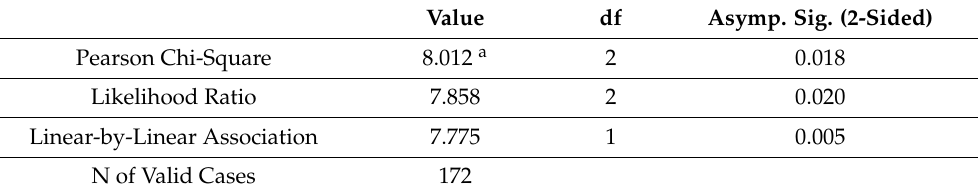
Table A2. A statistical significance between education and biochar